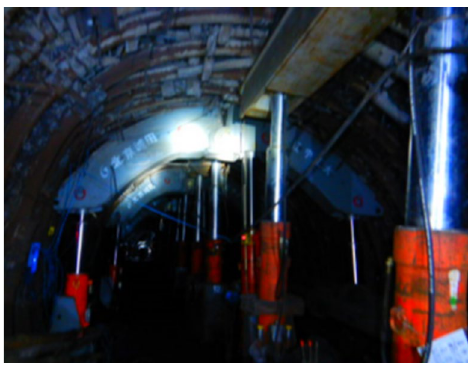
Figure 1. Field application of the supporting structure.